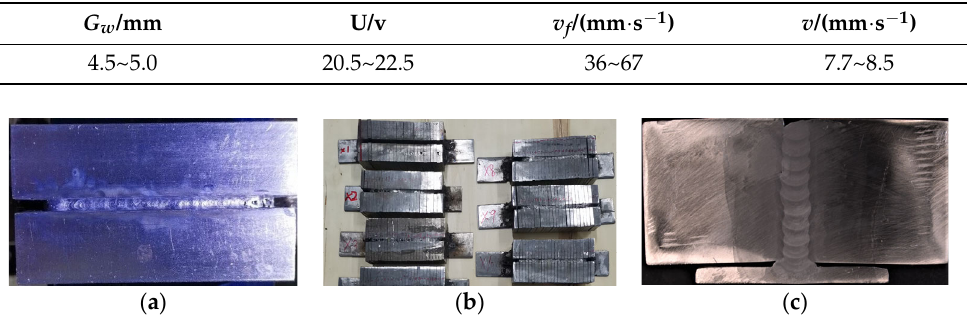
Table 1. Welding parameters range.